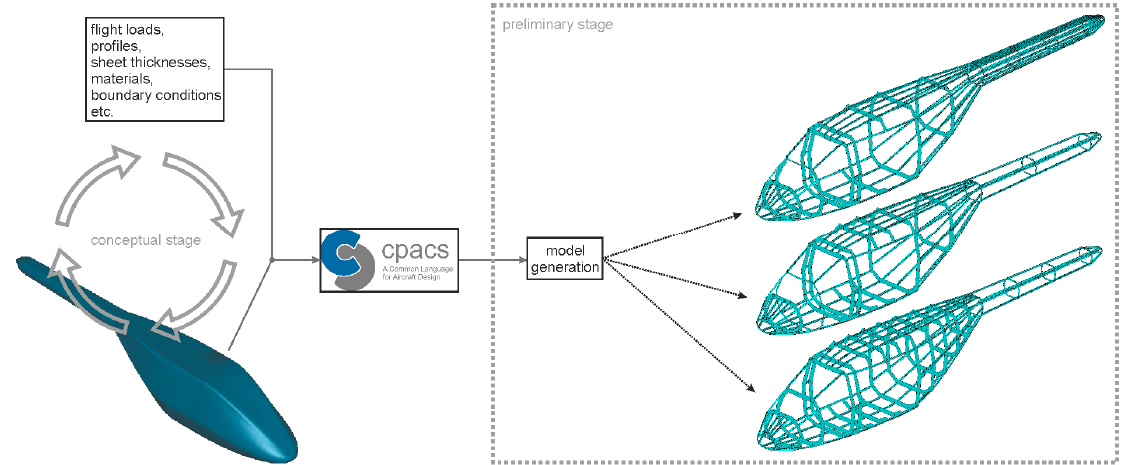
Figure 17. Finite element model preparation.